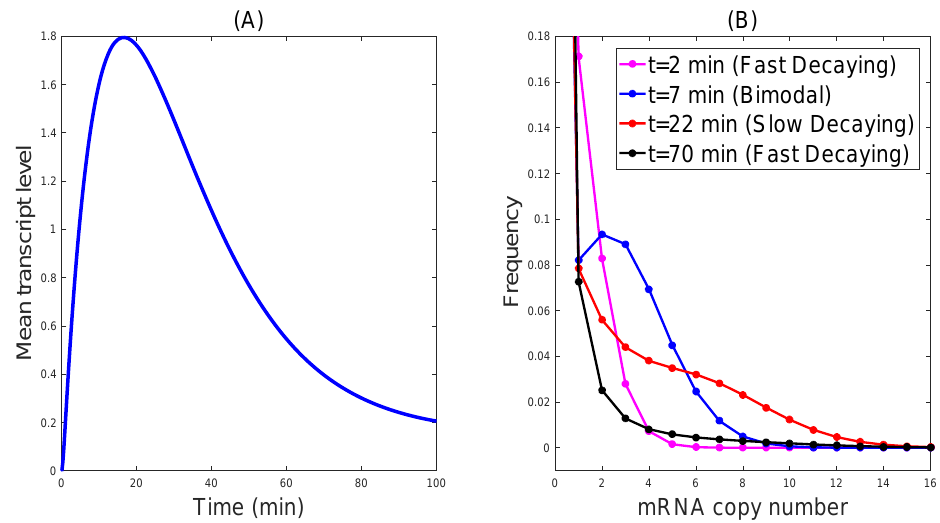
Figure 1. The dynamics of the distribution by cross-talking pathways generated with v = 0.63 min − 1 , δ = 0.063 min − 1 , λ 1 = 0.001 min − 1 , λ 2 = 3.151 min − 1 , q 1 = 0.51, q 2 = 0.49 and γ = 0.126 min − 1 . In ( A ), the observed mRNA average level behaves as up-and-down dynamics. In ( B ) the distribution transits from the decaying mode to the significant bimodality during a mediate time interval, and finally returns to decaying distribution.